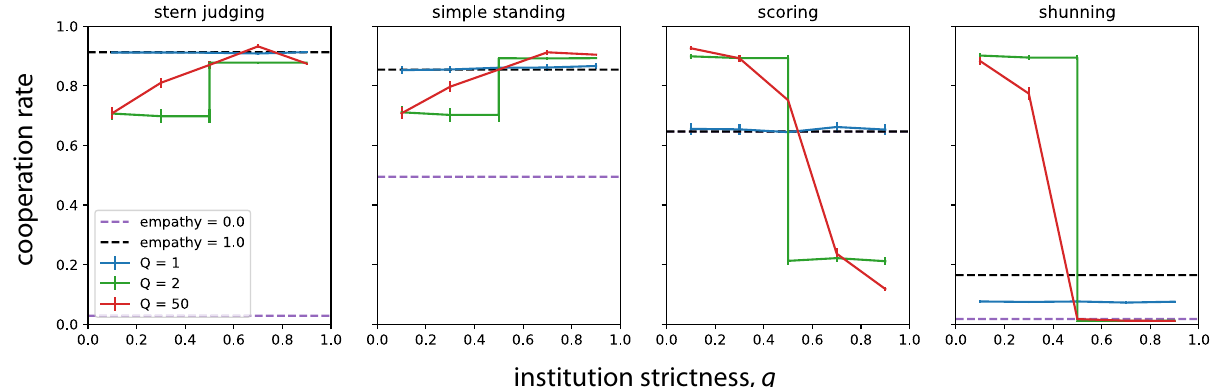
Fig. 3 Public institutions for moral assessment govern the level of cooperation as behavioral strategies are allowed to evolve. For each social norm, it is possible to specify a public institution of appropriate size ( Q ) and strictness ( q ) that induces far higher levels of stationary mean cooperation (solid lines) than in societies with private moral assessment (dashed lines). Public institutions can outperform even empathetic private assessment. The public institution that maximizes cooperation always requires more than Q = 1 individuals. Strict institutions (high q ) perform best under Stern Judging and Simple Standing, whereas tolerant institutions (low q ) perform best under Scoring and Shunning. Lines indicate the mean cooperation rate across 2500 replicate Monte Carlo simulations with population size N = 50, mutation rate μ = 0.025, error rates e 1 = e 2 = 0.02, and bene fi t and cost of cooperation b = 5 and c = 1. Error bars indicate 95% con fi dence intervals of the mean (±2 standard